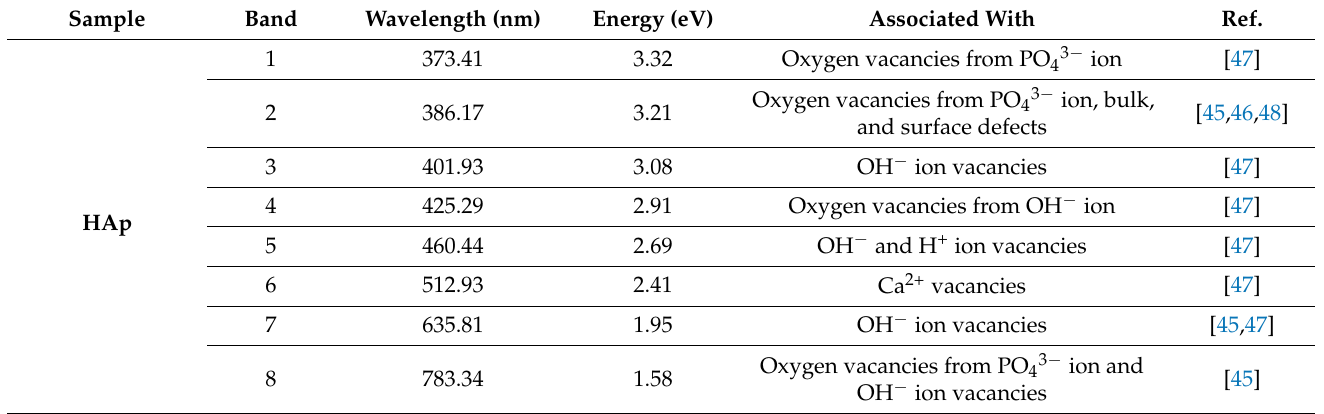
Table 4. Photoluminescence emission bands of the HAp and composite samples.